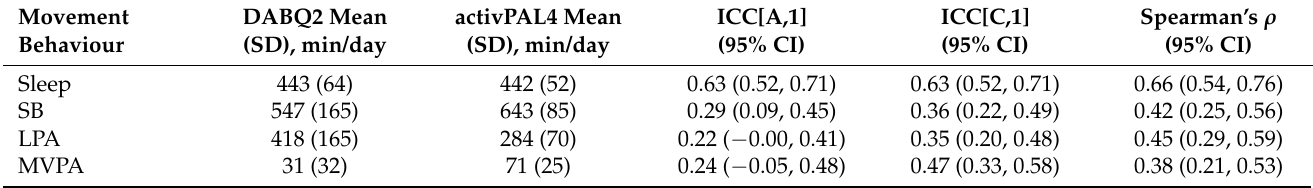
Table 3. Convergent validity of the Daily Activity Behaviours Questionnaire (DABQ) compared against activPAL4.